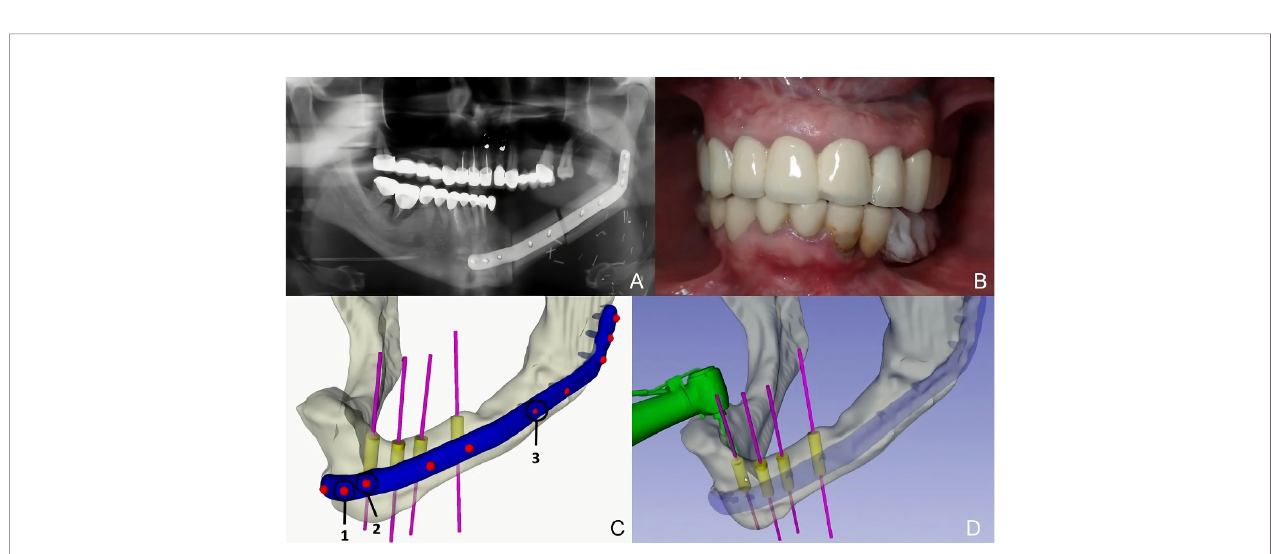
FIGURE 9 | (A) Recurrent ameloblastoma. (B) Virtual surgical planning of the oncologic resection with cutting guides. (C) Virtual reconstruction with fi bula free fl ap and customized titanium plate. (D) Cutting guides for fi bula fl ap. (E) Immediate reconstruction with fi bula fl ap and customized titanium